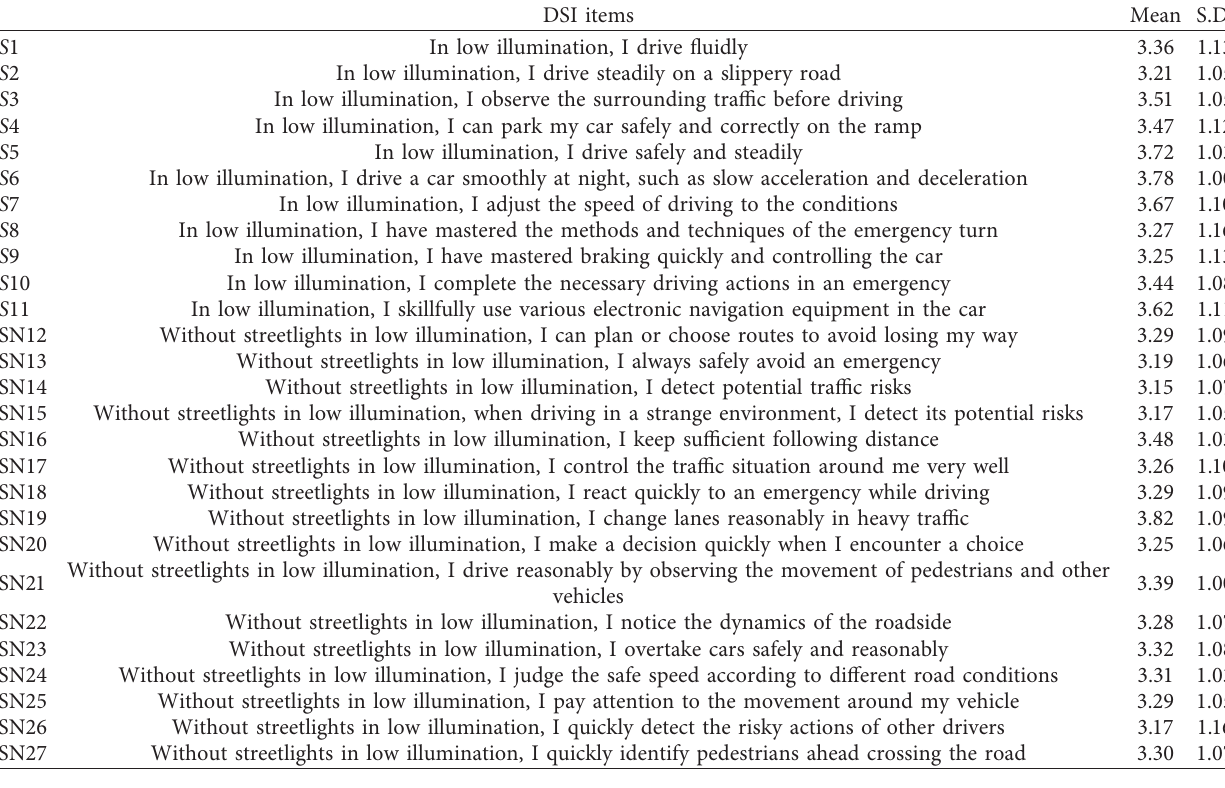
Table 4: Summary of the results for the DSI without streetlights in low